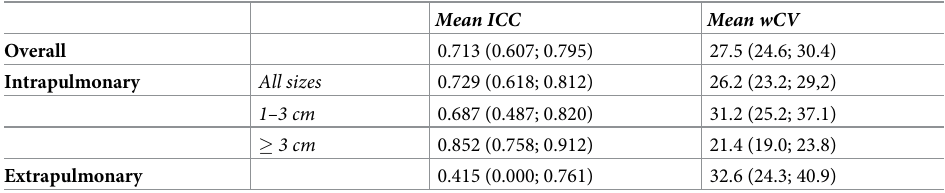
Table 4. Intrarater